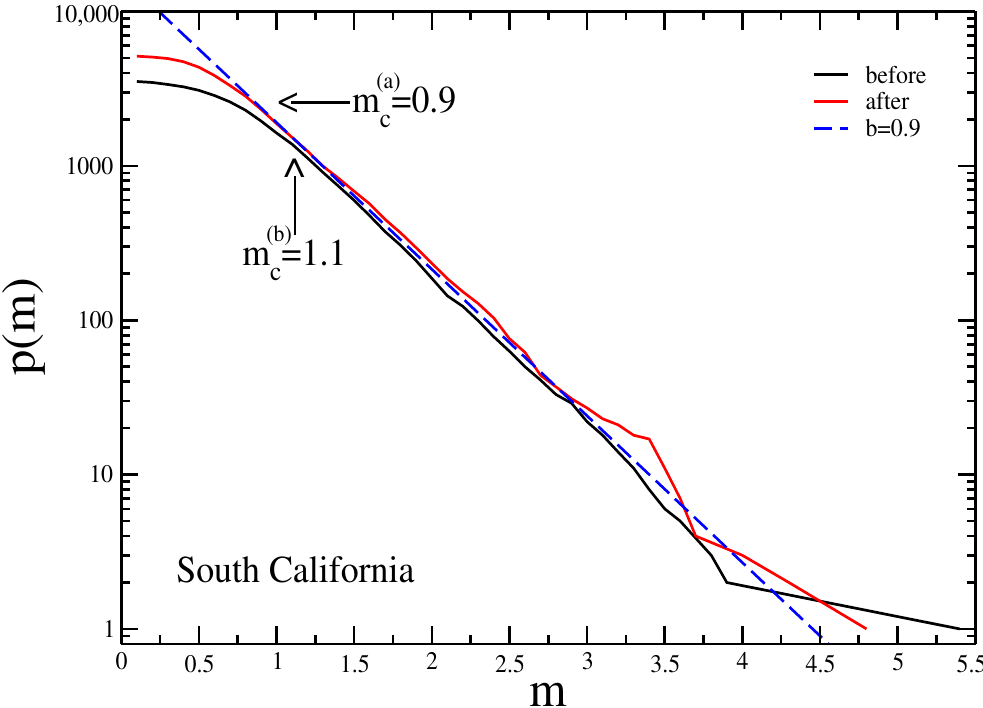
Figure 2. The Gutenberg–Richter distribution for the South California catalogue. The dashed line represents the fit for m ≥ m c